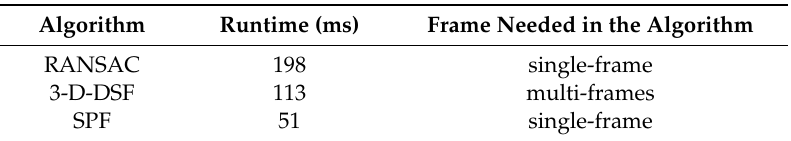
Table 3. The runtime of the three algorithms.